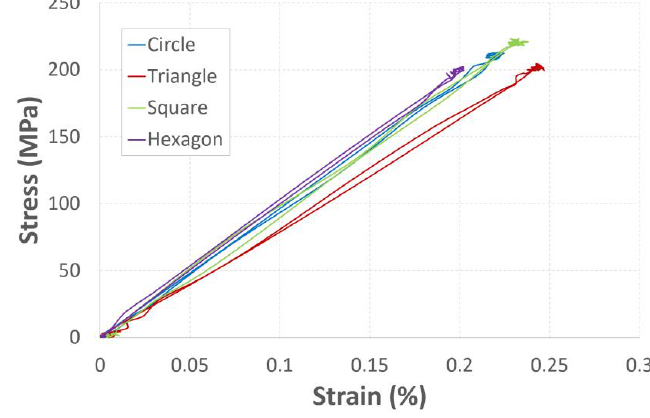
Figure 15. Dynamic behaviour under dynamic compression.